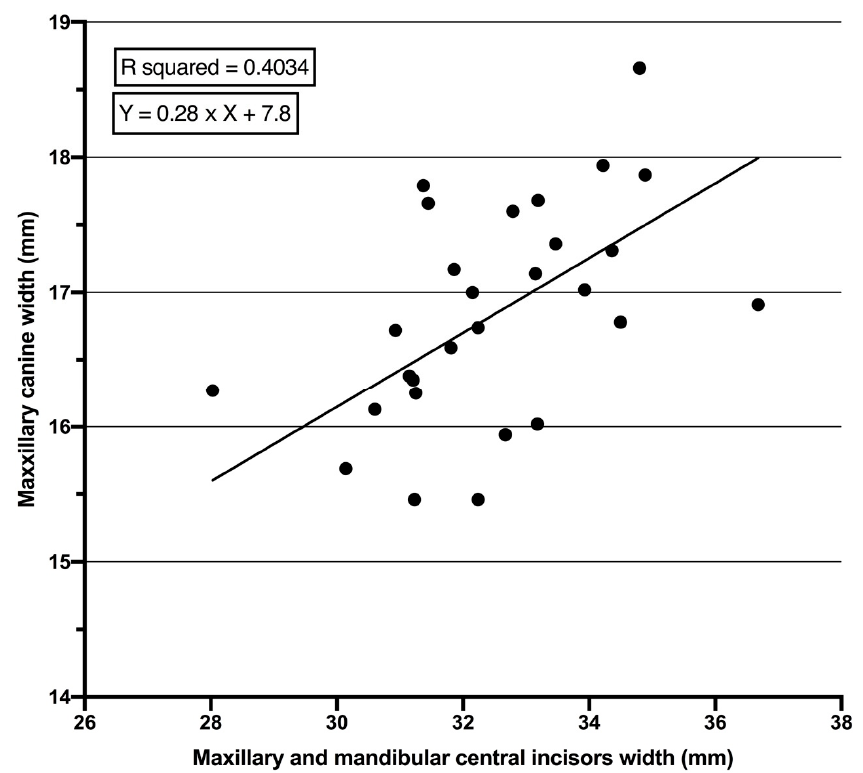
Figure 2. Linear regression line between mesio-distal widths of permanent maxillary and mandibular central incisors and mesio-distal widths of permanent maxillary canines in males. Children 2020 , 7 , x FOR PEER REVIEW